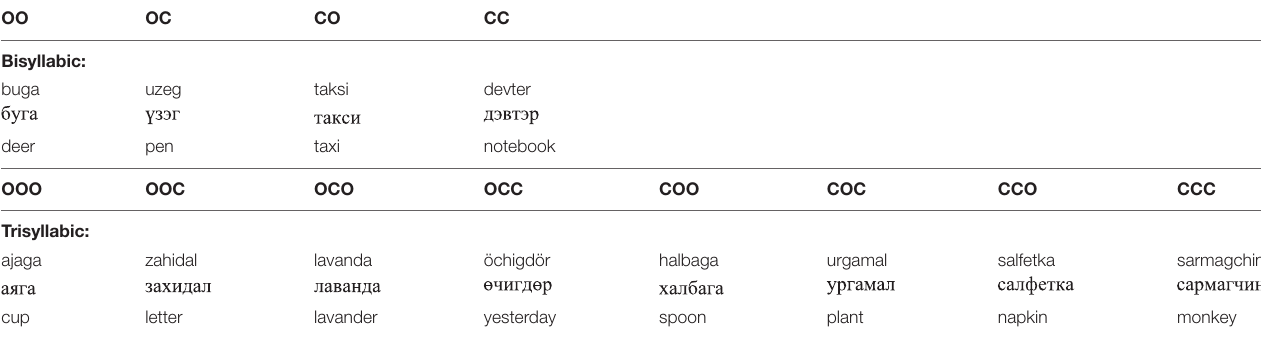
TABLE 2 | Example stimuli: words with all light